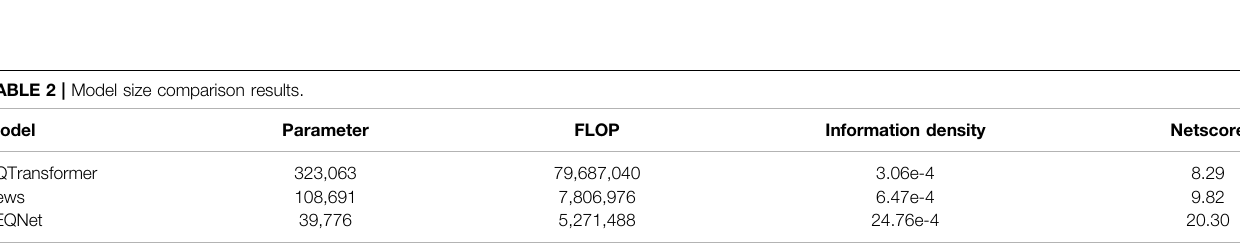
TABLE 2 | Model size comparison results.